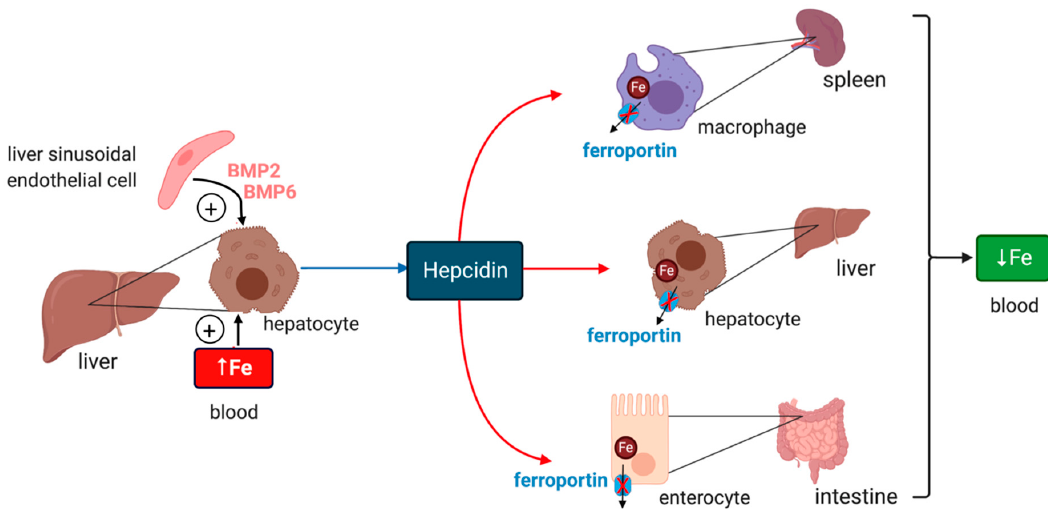
Figure 1. Hormonal regulation of systemic iron traffic by hepcidin. Hepcidin is synthesized in hepatocytes of the liver in response to hyperferremia iron or secretion of bone morphogenetic protein (BMP6) and BMP2 from liver sinusoidal endothelial cells; BMP6 secretion reflects increased body iron stores. It binds to the iron exporter ferroportin in target cells (red arrows) such as tissue macrophages, hepatocytes and intestinal epithelial cells and inhibits ferroportin-mediated iron efflux. Hepcidin binding directly inhibits iron e ffl ux from ferroportin and also promotes ferroportin internalization and degradation. These responses cause cellular iron retention and reduce plasma iron